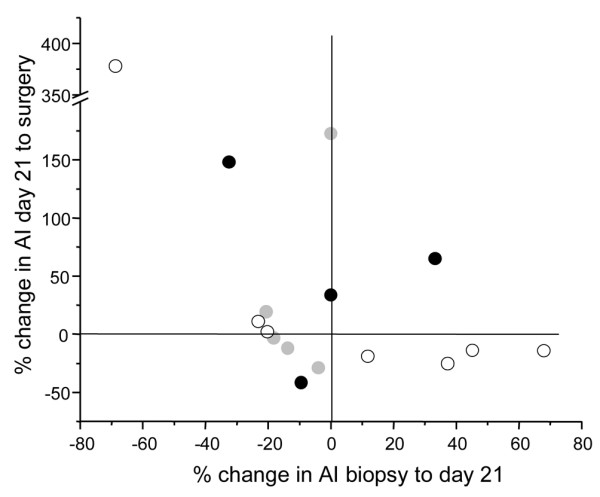
Changes in apoptotic LI during treatment and clinical and pathological response. The data are expressed as % change between initial biopsy and day 21 relative to the initial biopsy score (x-axis) versus % change between day 21 and surgery relative to the day 21 index. (●) represents patients with a complete clinical response, (●) with a partial response and (○) represents no response. The asterisks represent those patients who achieved a pathological response.